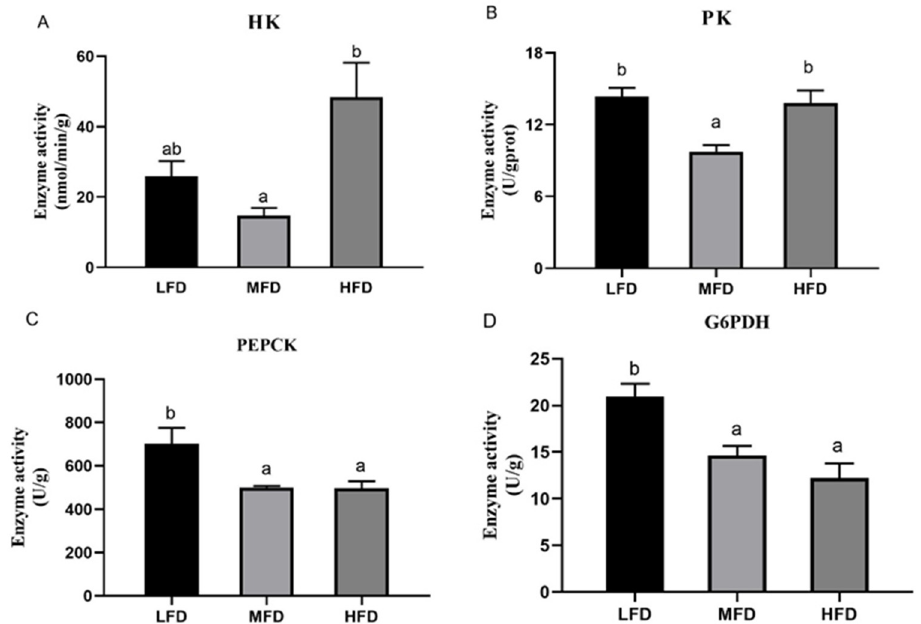
are presented as mean ± S.E., n = 3. Values with different letters are significantly different ( p < 0.05) .